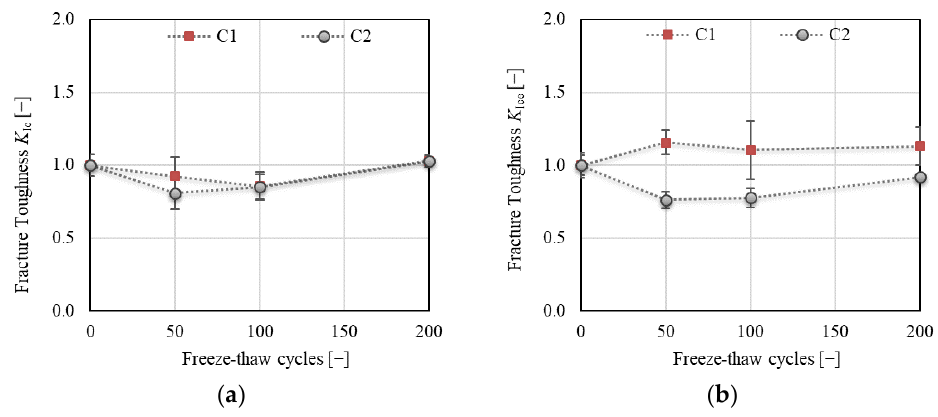
Figure 13. ( a ) Fracture toughness K Ic ; ( b ) effective fracture toughness K Ice .